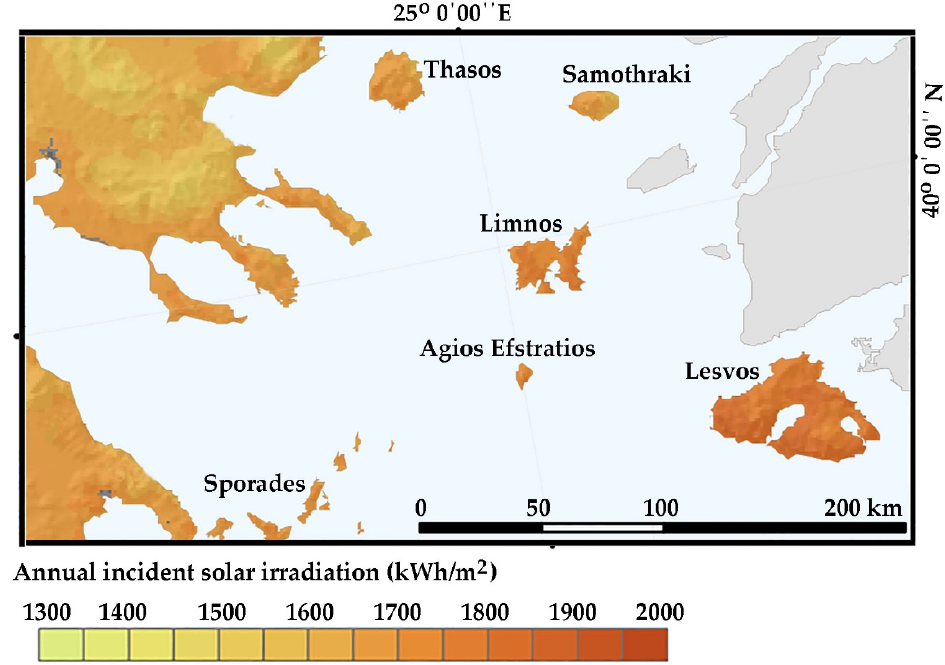
Figure 2. Yearly sum of global irradiation on the horizontal plane in the North Aegean Sea Greek islands [42].